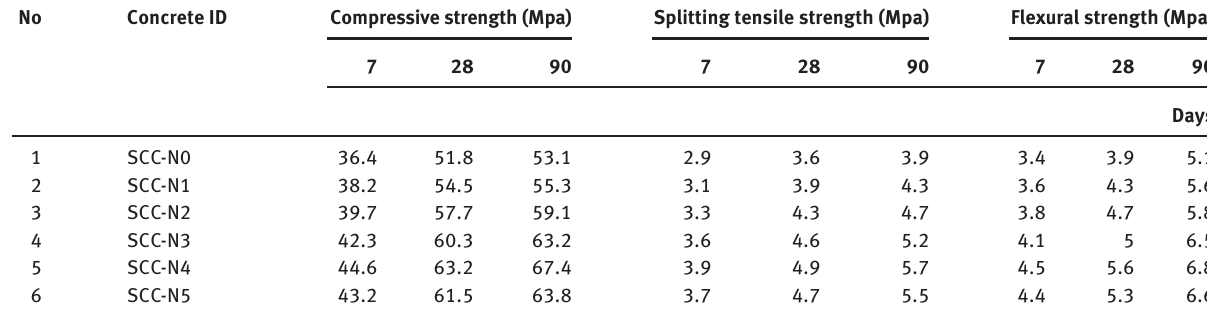
Table 4 Mechanical properties of SCC-N